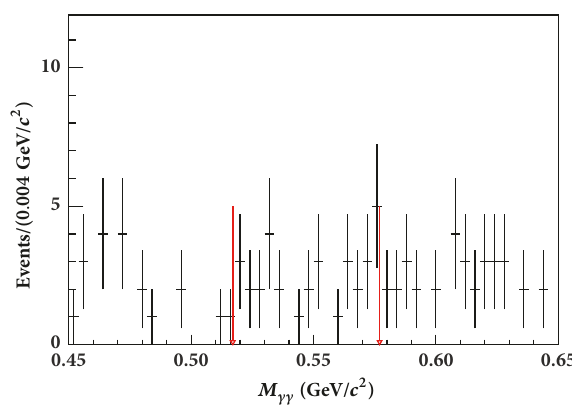
Figure 3: The 𝑀 𝛾 spectraof backgroundevents.The signal region 2 𝛾 3 of 𝑀 𝛾 is shown between the two arrows. 2 𝛾 3